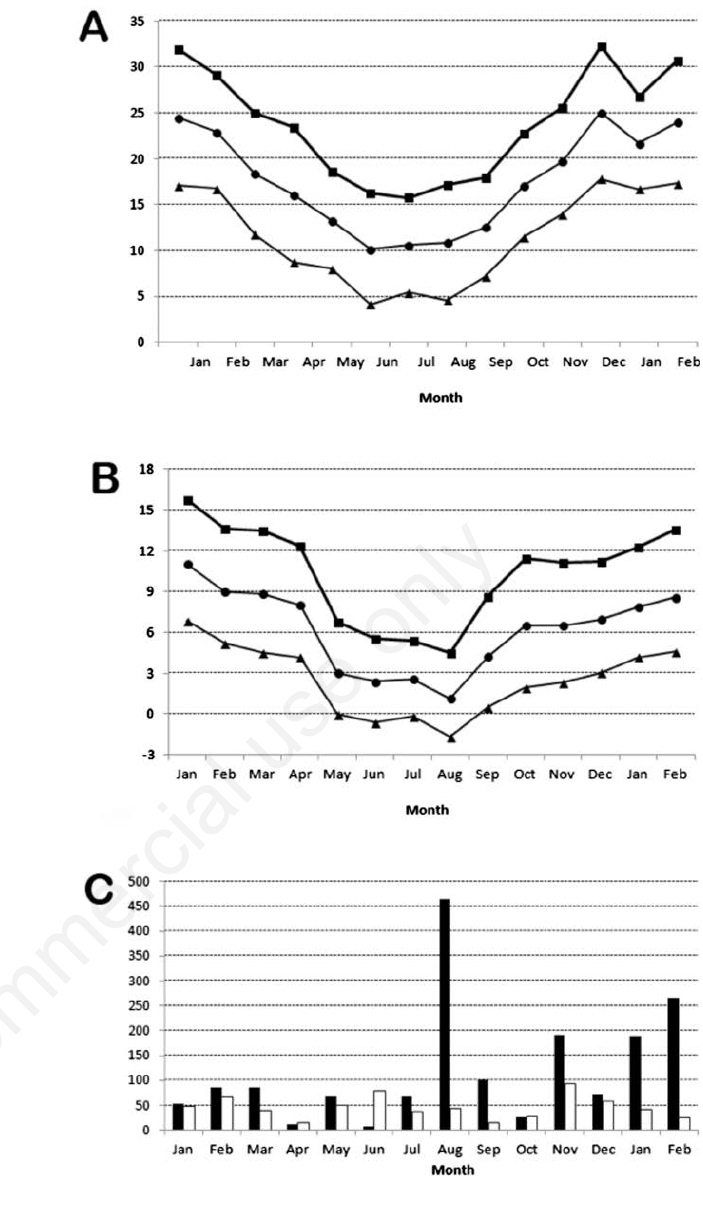
Figure 1. Temperature (A-B) and rainfall (C) registered by the Meteorological Station located at the Centro Austral de Investigaciones Científicas (Ushuaia, Tierra del Fuego, Argentina; B-C) and the Meteorological Station located at the Moreno experimental field (Buenos Aires, Argentina; A-C) from January 2013 to February 2014. A-B) Mean (circle),